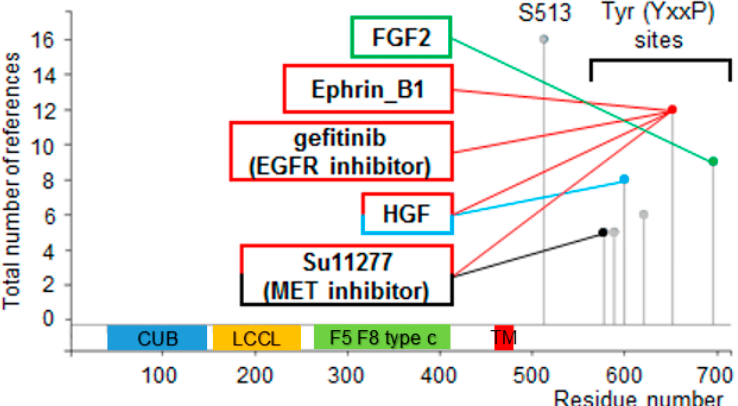
Figure 5. Phosphoproteomic bioinformatical analysis of the DCBLD1 protein. PhosphoSitePlus ® analysis shows one frequently detected S513 phosphorylation site of unknown function and six YxxP sites. Four of the six sites are linked with three different receptor tyrosine kinases.